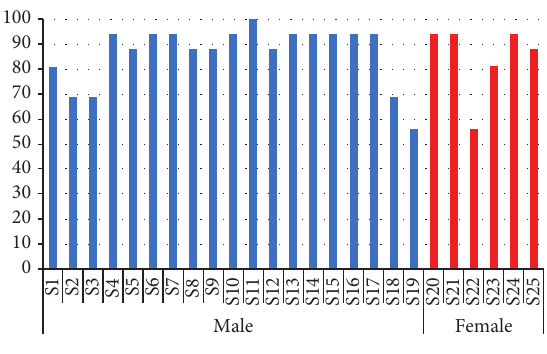
Figure 8: Ease of learning.